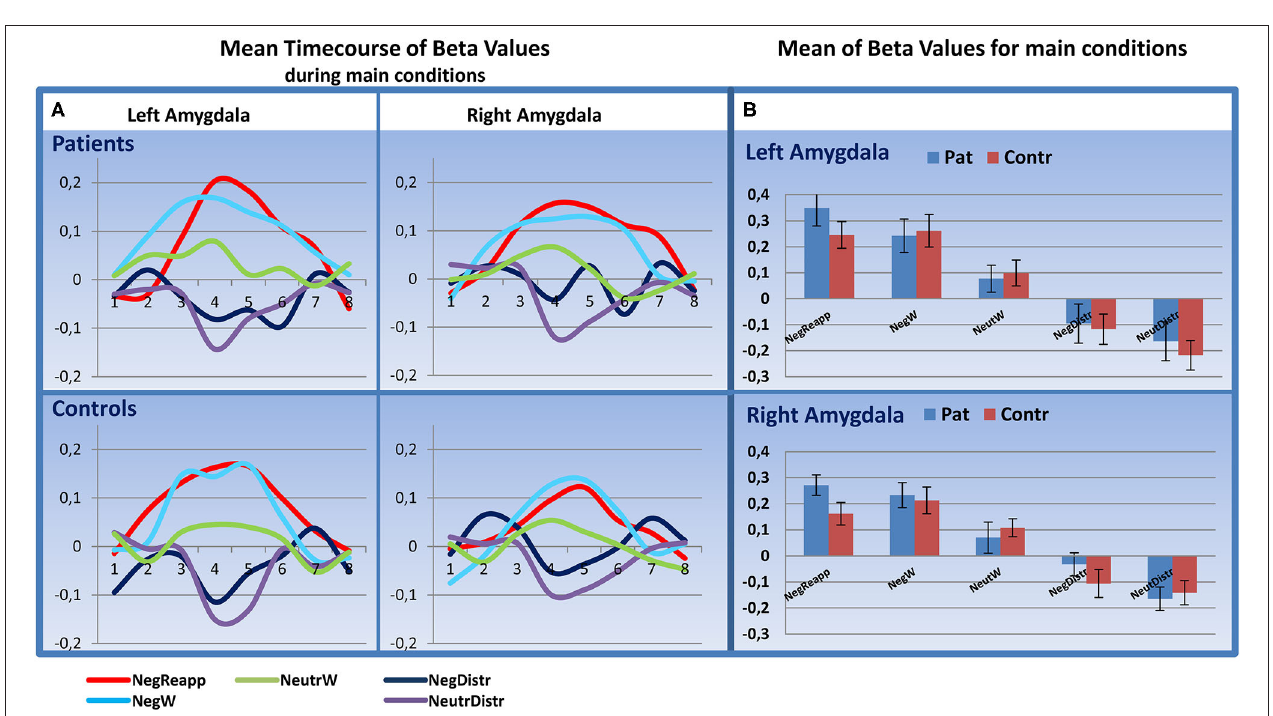
FIGURE 3 | Time course analysis in the amygdala. (A) Mean Timecourse of Beta Values for 20s (8 timebins à TR 2,500ms after start of presenting the image) in the left and right amygdala: similar upregulation for NegReapp and NegW in both amygdala for patients and controls ( n = 24, each group). (B) Mean Beta Values with standard error of mean for all main conditions indicate as well an upregulation in both amygdala during NegReapp and a downregulation for the distraction conditions NegDistr and NeutrDistr. [main conditions: NegReapp: Reappraisal while watching negative images; NegW: watching negative images; NeutrW: watching